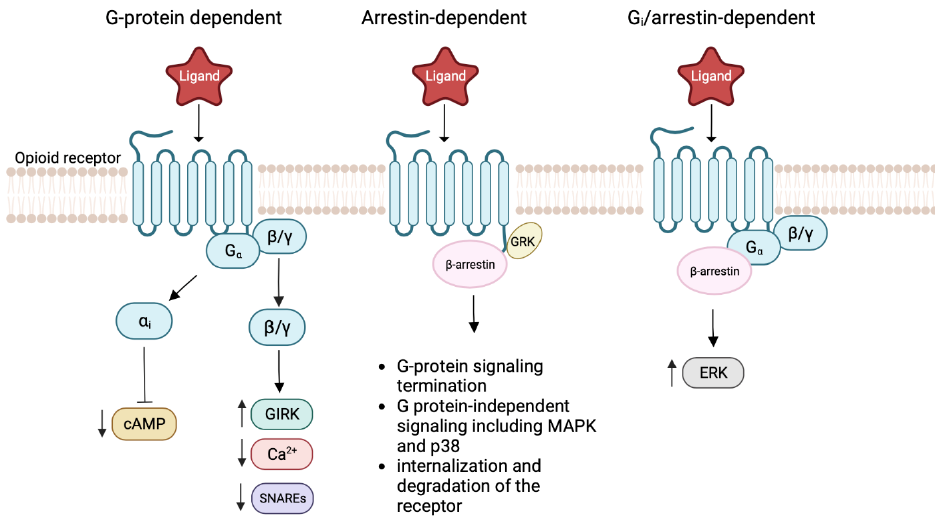
Figure 2. Biased signaling of MOR. The figure on the left shows the coupling between G proteins and MOR after ligand binding, leading to a reduction of cAMP, decreased Ca 2+ signaling, and the activation of GIRK channels. In the middle, GRK phosphorylated the receptor, resulting in β-arrestin recruitment. This leads to receptor internalization and degradation. Meanwhile, β-arrestin mediates other signaling pathways, including those of MAPK and p38. The figure on the right shows the interaction between the Gαi subunit and β-arrestin. These two proteins form a complex that mediates various signaling pathways such as the activation of ERK.